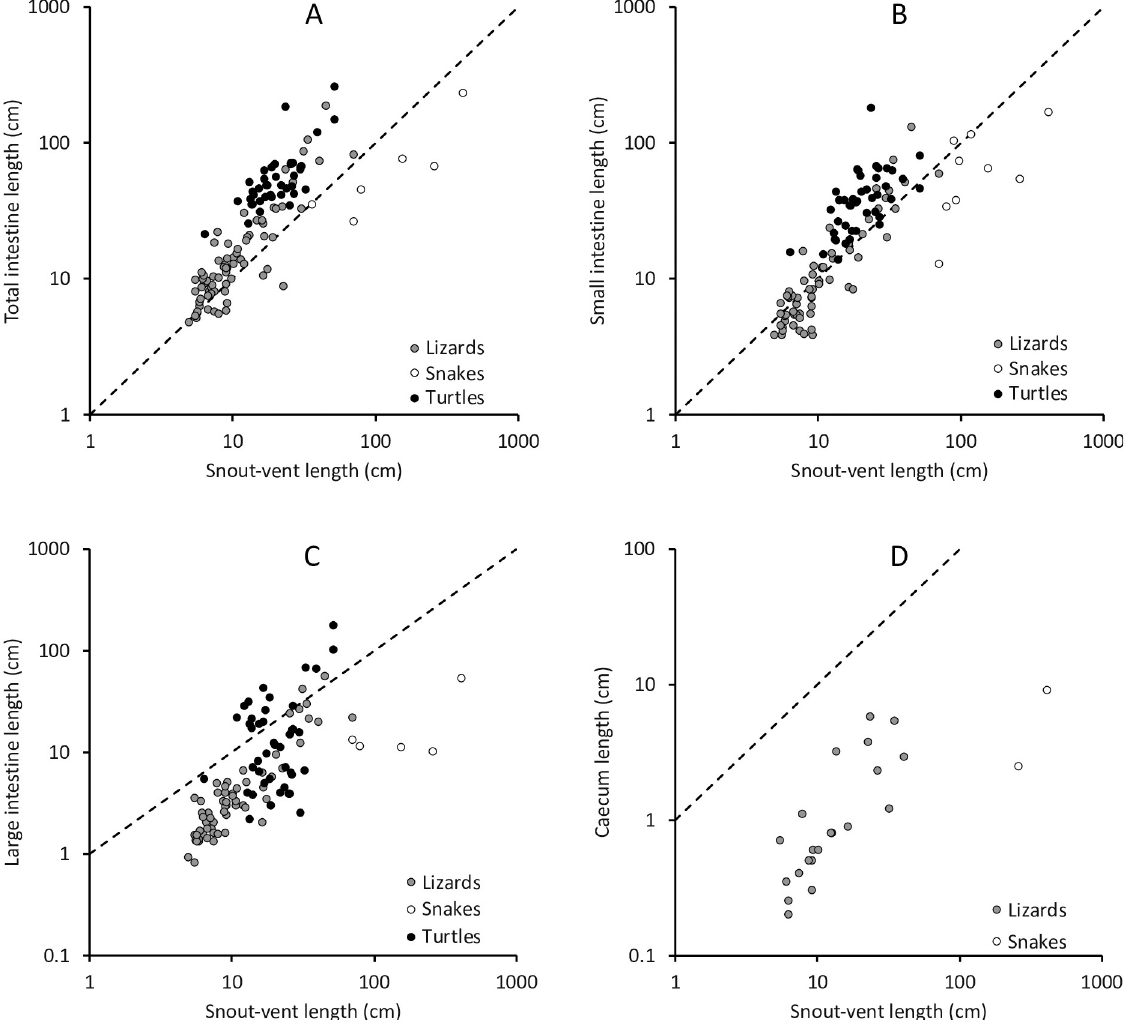
Fig 4. Relationship of snout-vent-length (SVL) and intestinal length in reptiles for (A) the total intestine, (B) the small intestine, (C) the large intestine, (D) caecum, for taxonomic groups. Note that snakes are all faunivorous and have, at a similar intestine length, a similar body mass as other reptiles, but a longer body length. For statistics, see S8 Table in S1 File. The dotted line represents y = x to facilitate gauging the slope of the length-length